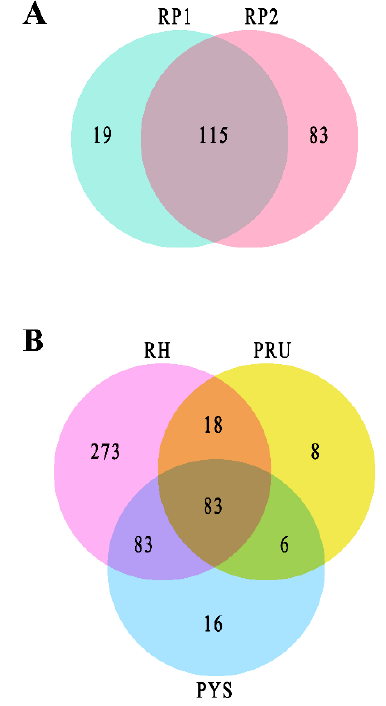
Figure 7. Global identification of lysine acetylation in T. gondii PRU strain. Venn diagrams show the number of unique and common acetylated proteins in RP1 and RP2 of ( A ) PRU strain. ( B ) Venn diagram shows the number of unique and common acetylated proteins between RH strain, PRU strain, and PYS strain. RP1 and RP2 indicate biological replicate 1 and biological replicate 2, respectively.